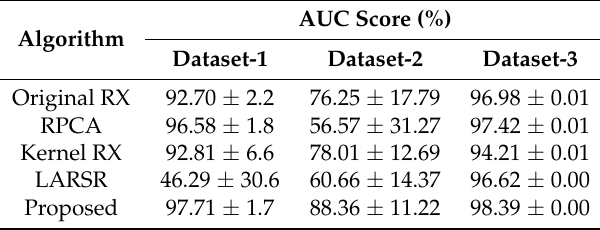
Table 8. AUC score (For Dataset-1 and Dataset-2, we calculate the average AUC and standard deviation of each patch).